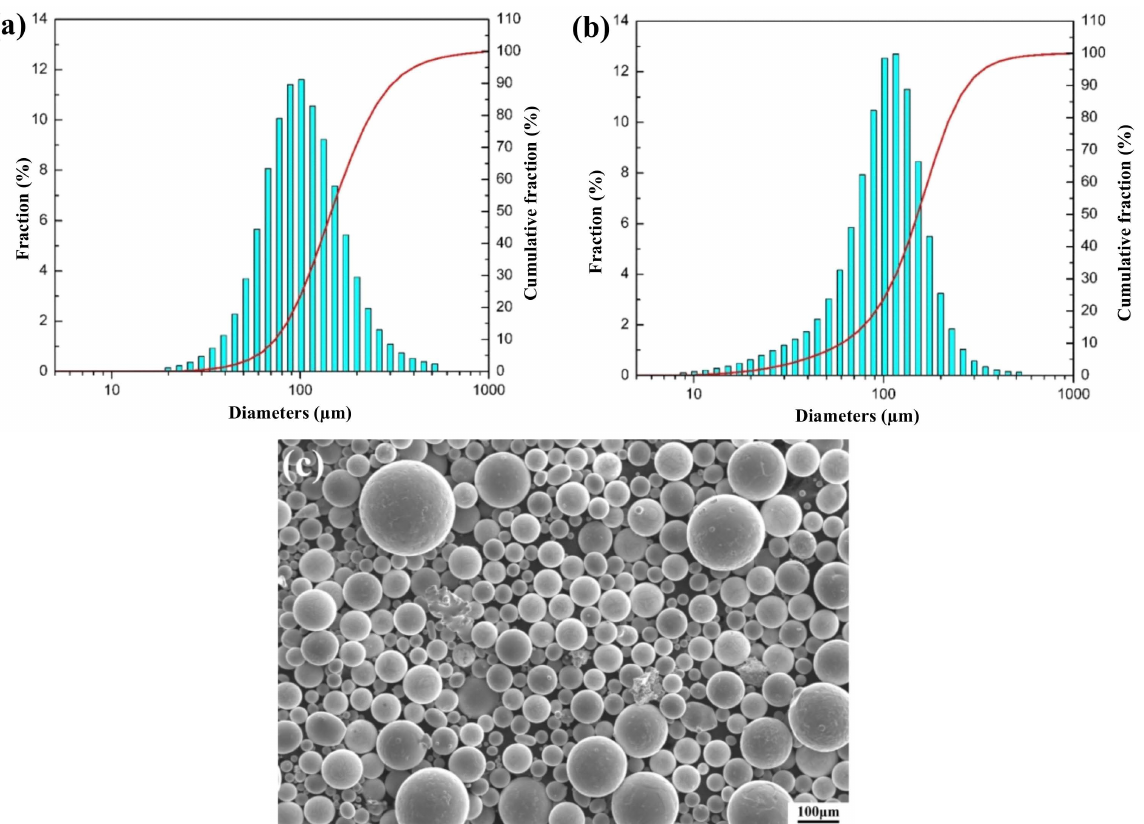
Figure 6. Particle size distribution and cumulative distribution curve of the actually prepared powder: ( a ) 80-mesh sieve powder and ( b ) 100-mesh sieve powder. ( c ) SEM image of powder prepared at an atomization pressure of 12